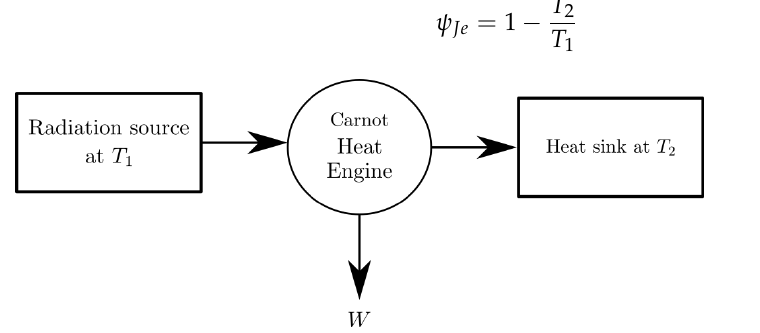
Figure 2. Carnot heat engine receiving radiation and converting it into work